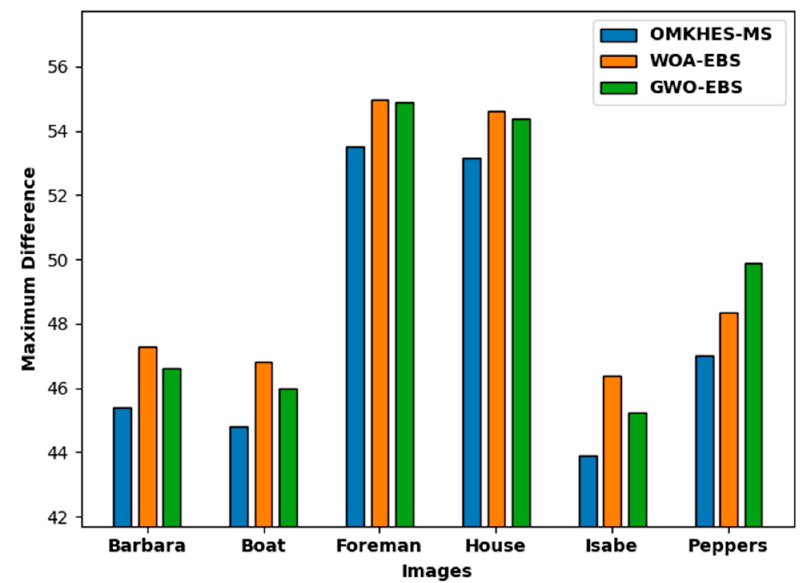
Figure 11. Comparative MD analysis of OMKHES-MS technique with existing models.